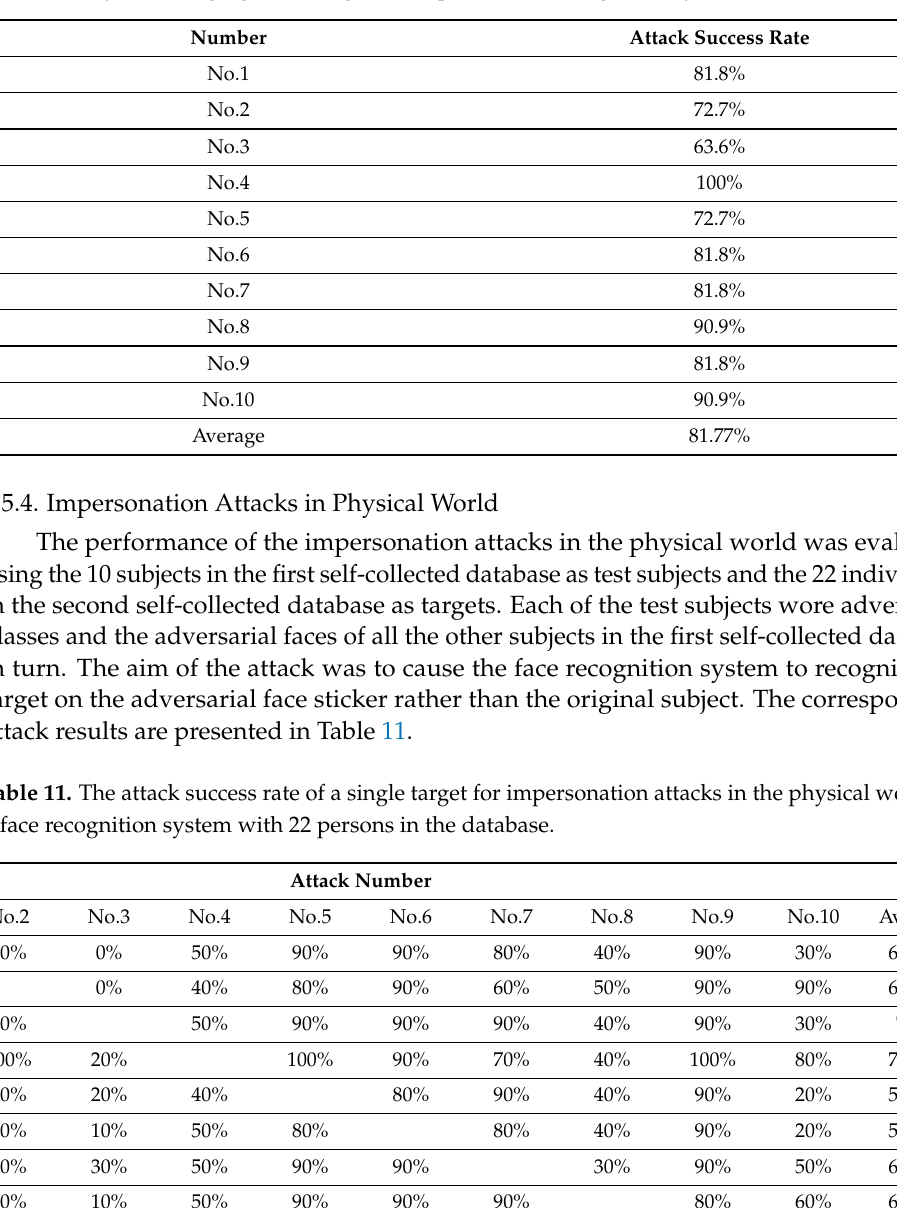
Table 10. Physical dodging attacks against 22-person face recognition system.